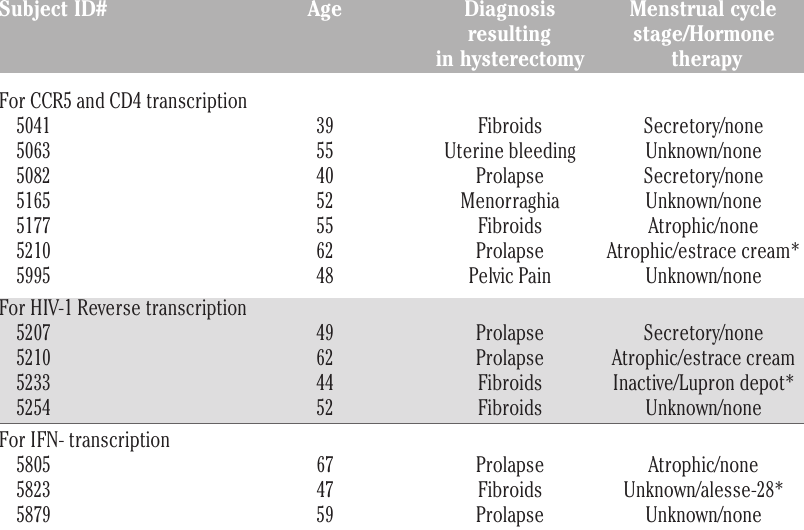
Table 1. Clinical summary of hysterectomy